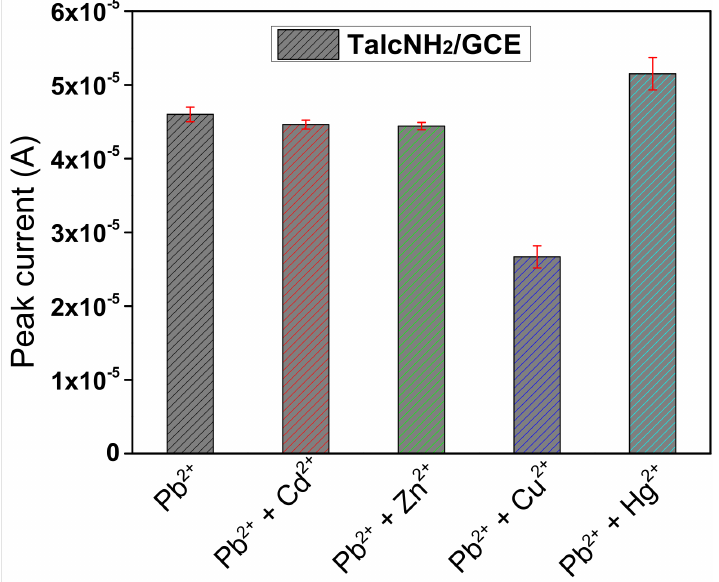
Figure 13. Interference studies of TalcNH 2 /GCE at 5 µ M Pb 2+ ions in the presence of 5 µ M Cu 2+ , Cd 2+ , Zn 2+ and Hg 2+ ions under optimal experimental conditions. Experiments were performed in